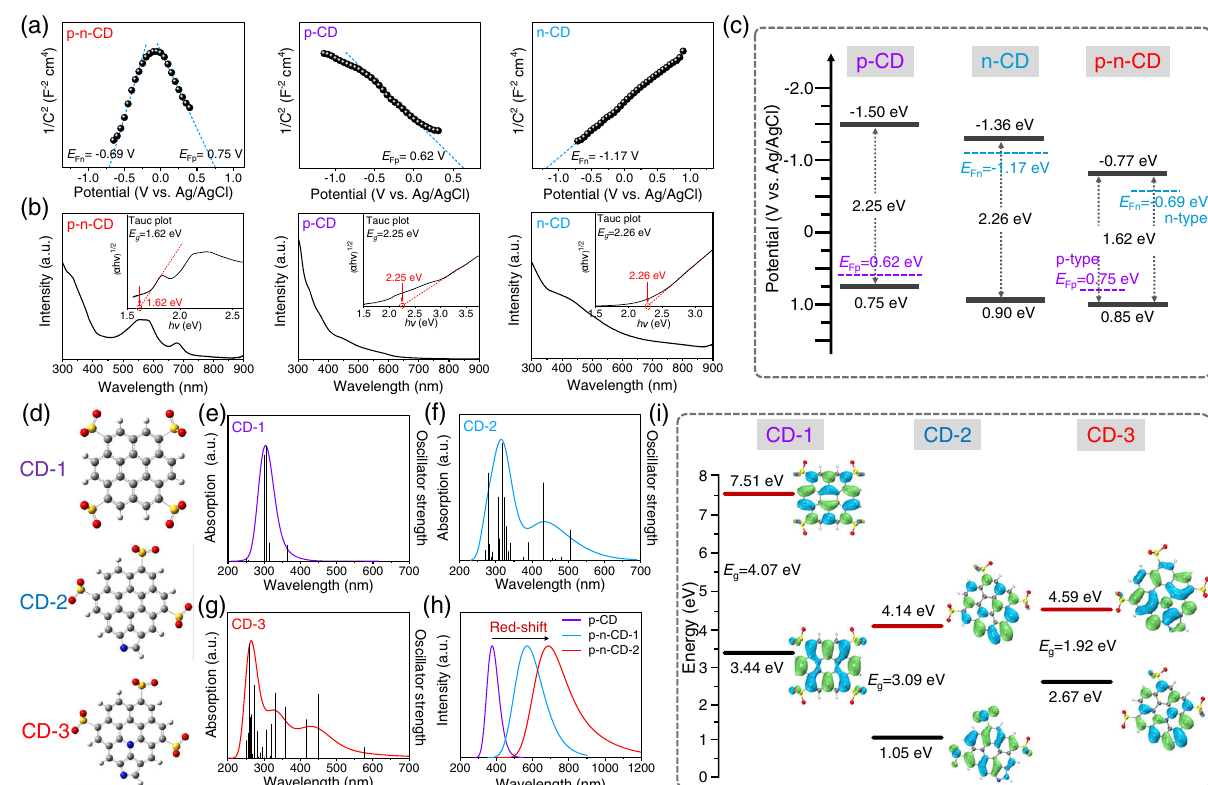
Fig. 3 | Tuning electronic structures of CDs with different modi fi cations. a Conductivity type identi fi cation of CDs by measuring varied capacitance ( C ) with the applied potential in the Mott-Schottky relationship. The symbols E Fp and E Fn represent the Fermi levels of the p- and n-type semiconductors. b Absorption spectra and corresponding Tauc plots of p – n-CDs, p-CDs, and n-CDs. c Schematic illustration of the energy-band diagrams of the p-CDs, n-